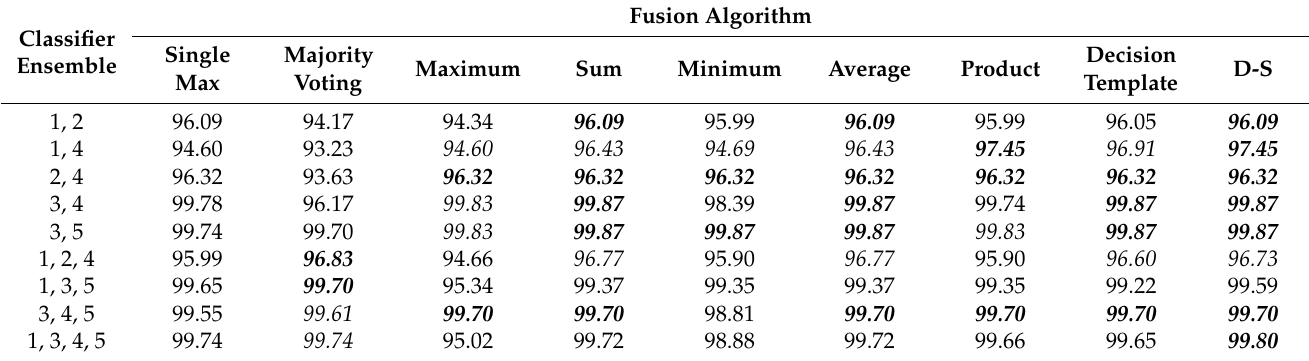
Table 6. The accuracies of the related multiple classifier fusion models (%).